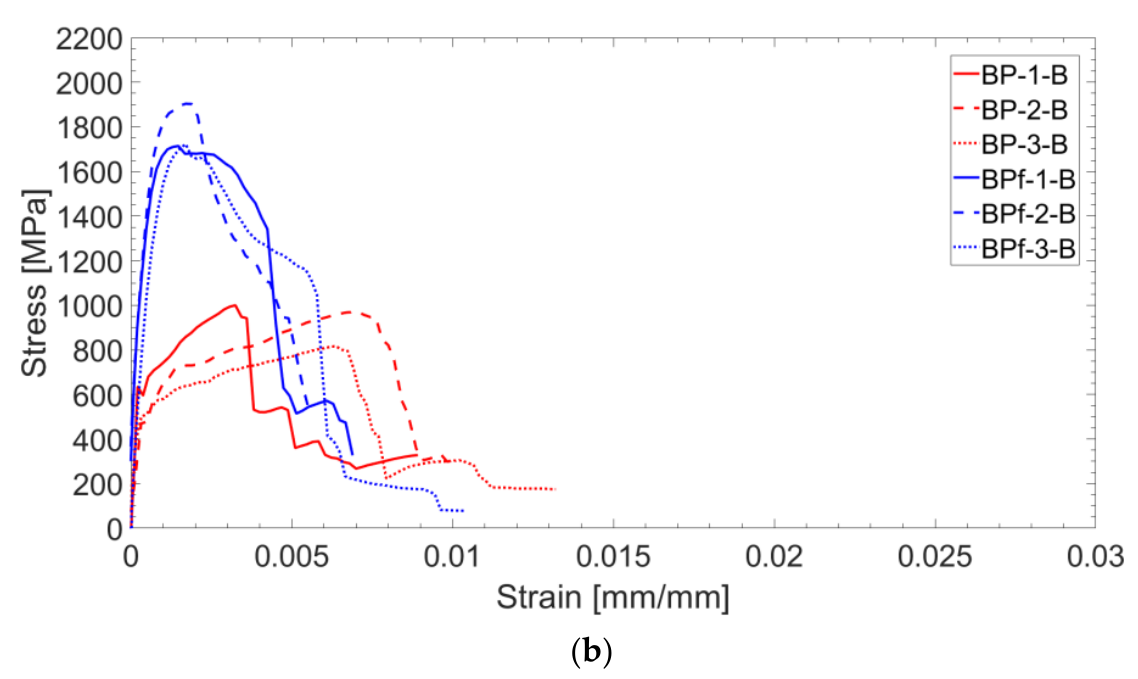
Figure 14. Force – displacement ( a ) and stress-strain ( b ) curves of B-TRC specimens (in red) and B-F/TRC specimens (in blue).